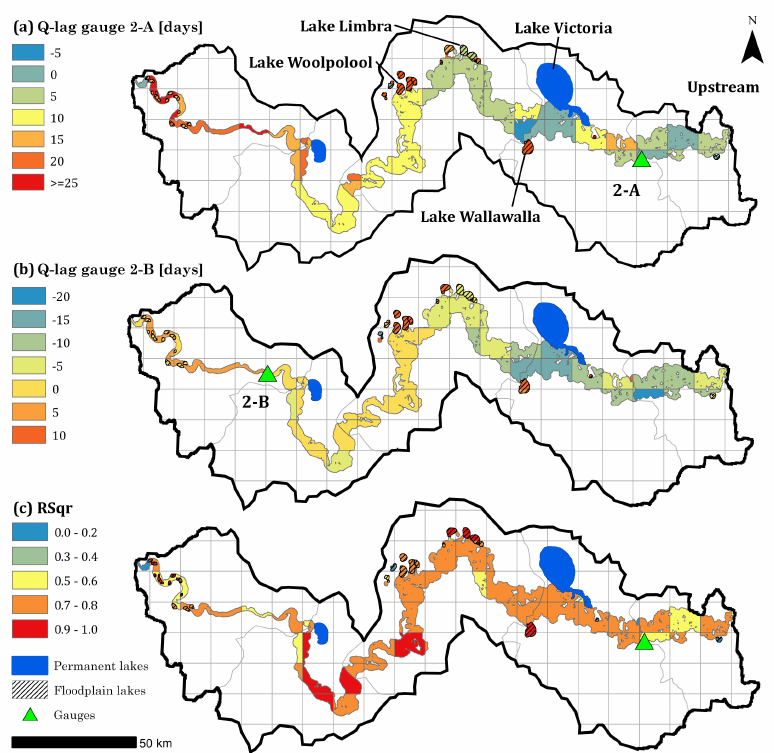
Figure 4. Model results of the Murray sub-region: (a) Q lags for river gauge 2-A, (b) Q lags for river gauge 2-B, and (c) r 2 of floodplain and floodplain lakes (final models).